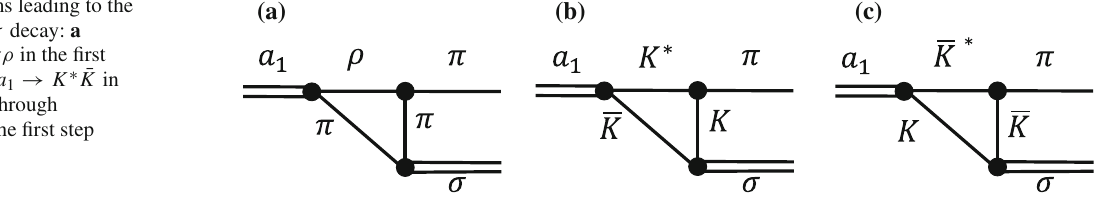
Fig. 1 Diagrams leading to the a